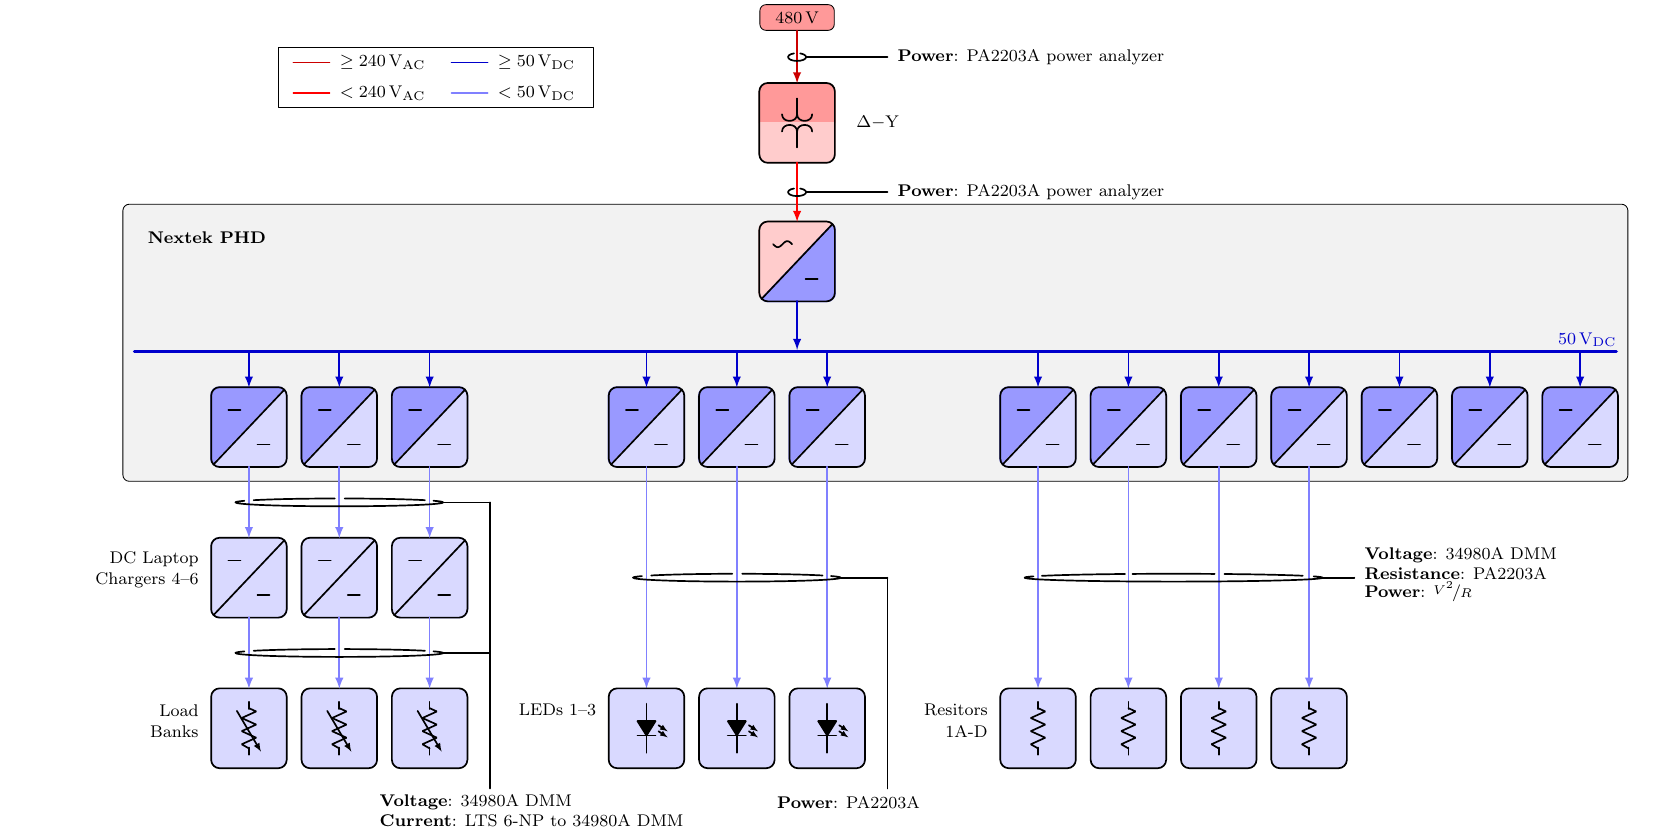
Figure A6. Electrical diagrams for Scenarios 5.3 and